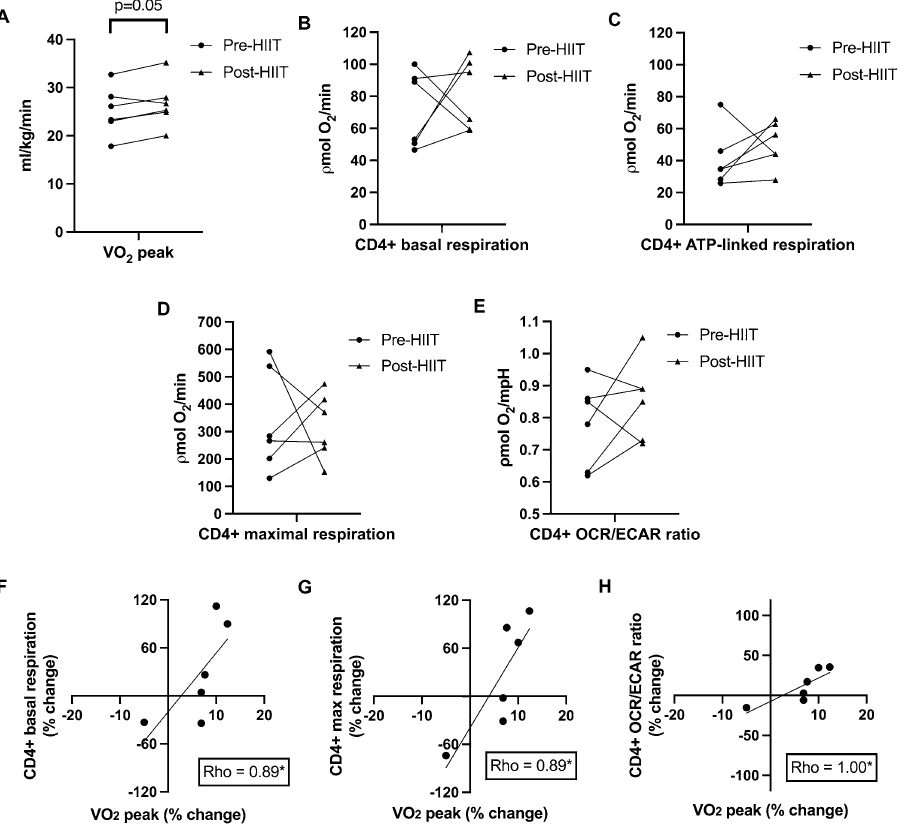
Figure 1. HIIT improves cardiorespiratory fitness in association with changes in RA CD4 + T cell oxidative function. Graphs show changes from before (Pre-HIIT) to after (Post-HIIT) high-intensity interval training (HIIT) in individual rheumatoid arthritis (RA) participant (subgroup n = 6) ( A ) cardiorespiratory fitness (relative VO 2 ; ml/kg/min) and peripheral CD4 + T cell ( B ) basal, ( C ) ATP-linked, and ( D ) maximal respiration (oxygen consumption rate; ρmol O 2 /minute), and ( E ) basal oxygen consumption rate (OCR)/extracellular acidification rate (ECAR) ratio (OCR/ECAR ratio; ρmol/mpH). ( F ) Scatter plot depicts relationship between percent change in RA peripheral CD4 + T cell basal respiration (y-axis) and percent change in relative peak VO 2 (x-axis) following HIIT. ( G ) Scatter plot depicts relationship between percent change in RA peripheral CD4 + T cell maximal respiration (y-axis) and percent change in relative peak VO 2 (x-axis) following HIIT. ( H ) Scatter plot depicts relationship between percent change in RA CD4 + T cell OCR/ECAR ratio (y-axis) and percent change in relative peak VO 2 (x-axis) following HIIT. * p < 0.05 for paired t-tests and Spearman